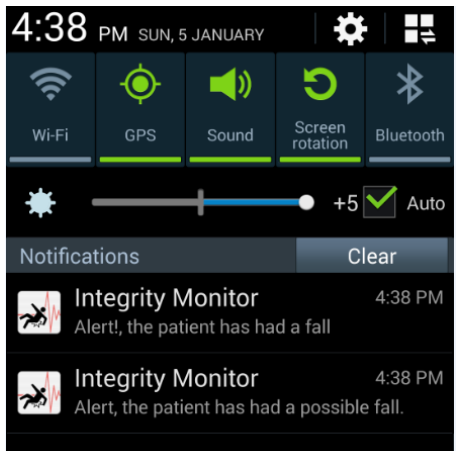
Figure 10. Push notifications from the generated